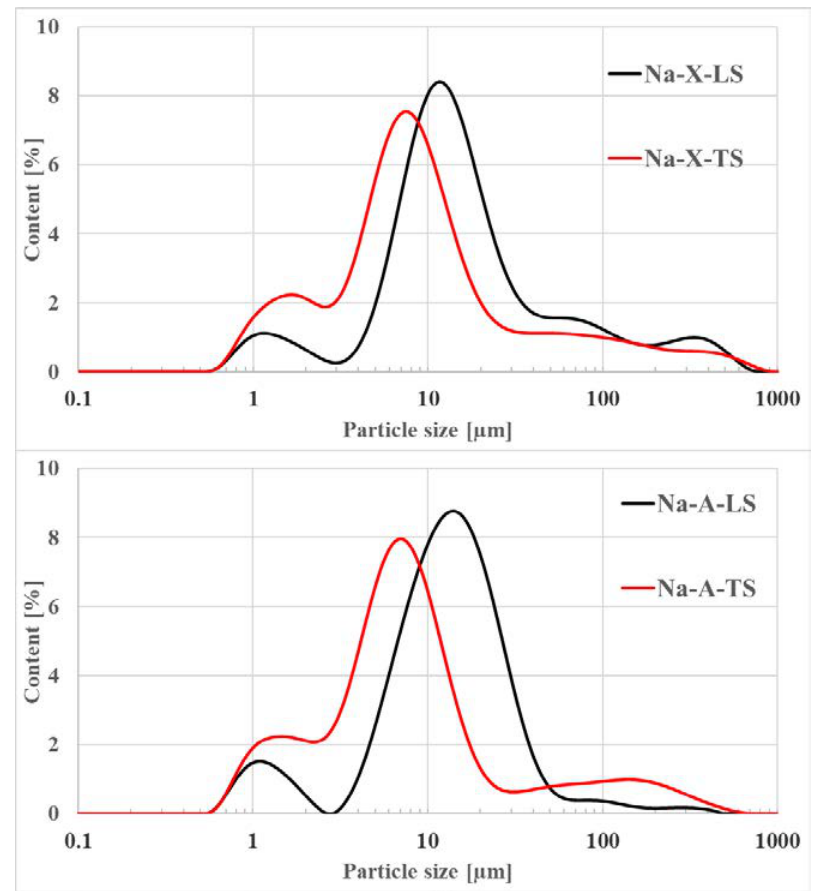
Figure 1. Particle size distribution curves for studied zeolites.